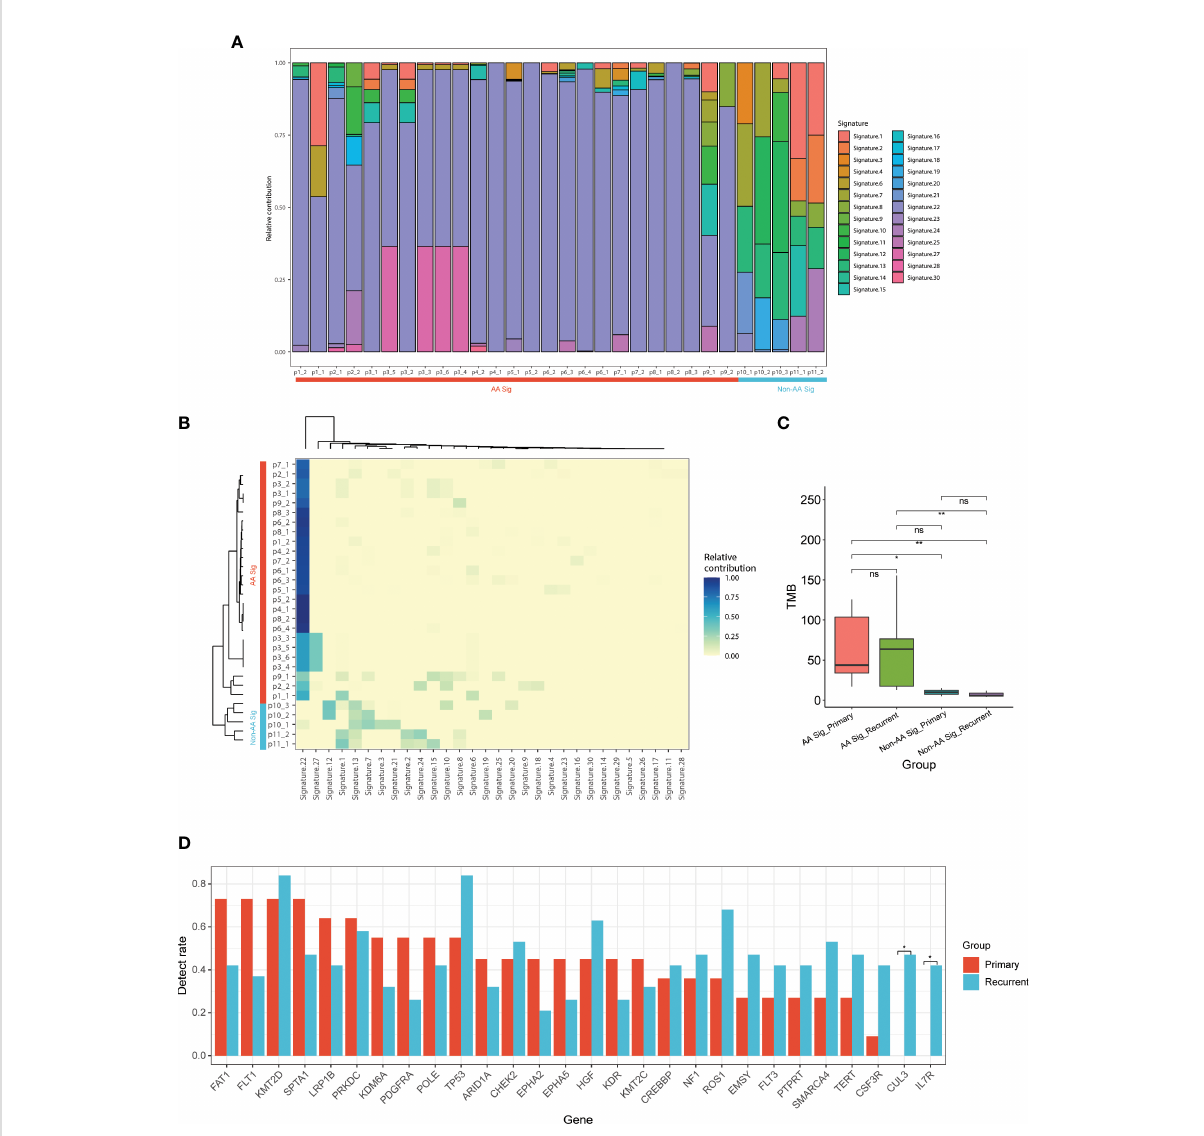
FIGURE 3 Mutational signature of primary and recurrent tumors in AA UC and non-AA UC cohorts (A) Landscape of mutation signatures of all the primary and recurrent tumor samples. (B) Hierarchical clustering of mutation signatures in all samples. (C) Bar plot of TMB representing median TMB for primary and recurrent tumors in AA UC and non-AA UC cohorts. (D) The detection rate of the top 28 mutated genes in all patients. *p < 0.05; **p < 0.01; ns, not signi fi